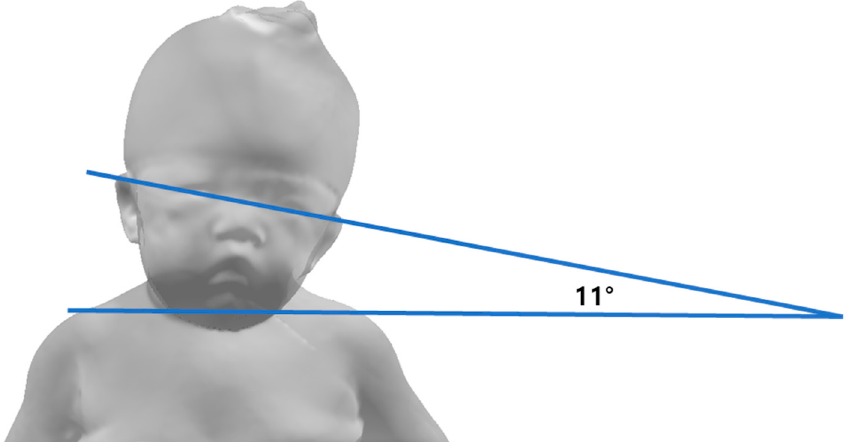
Figure 2. Still photography